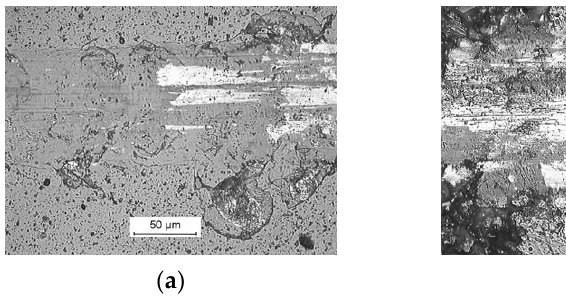
Figure 5. Optical images of the coating failure during the scratch test: ( a ) Group I substrate, sintering temp. 1250 °C, Lc3 (76.4 N); ( b ) Group II substrate, sintering temp. 1050 °C, Lc3 (22.8 N); ( c ) Group III substrate, sintering temp. 1350 °C, Lc3 (69.5 N).